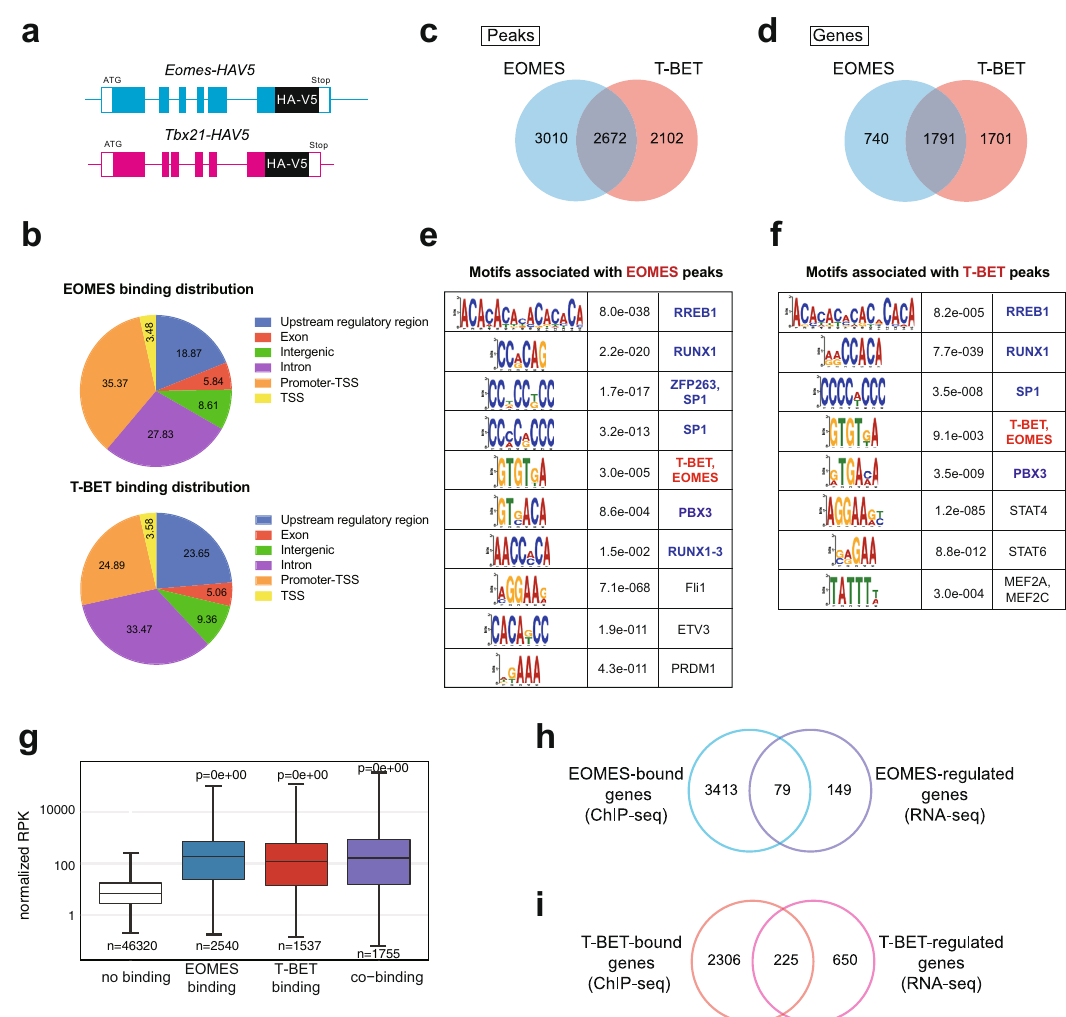
Fig. 8 Identi fi cation of direct T-BET and EOMES targets using novel KI mice. a Scheme of knock-in Eomes and T-bet HAV5 constructs. b Distribution of EOMES and T-BET peaks relative to different genomic features. “ Upstream regulatory regions ” refers to regions located − 20 kb/ − 1 Kb away from the TSS, “ promoter-TSS ” refers to regions located − 1 Kb/ + 100 bp around the TSS and “ TSS ” refers to regions located − 100 bp/ + 1 Kb around the TSS. c Venn diagram showing the overlap between EOMES and T-BET ChIP-seq peaks. d Venn diagram showing the overlap between genes nearby EOMES and T-BET ChIP-seq peaks. e – f Motifs associated with ( e ) EOMES or ( f ) T-BET peaks and corresponding TFs ( E -values are shown, not ranked). g Boxplot presenting expression (RNA-seq data) of genes bound by T-BET and/or EOMES (Chip-seq data). Expression of genes without any of them is shown as reference. The number of genes analyzed is indicated in the fi gure. Minimal and maximal values are shown. The centre gives the mean expression and the box gives the 10 – 90 percentile. P values were calculated by Wilcoxon signed-rank tests. h Venn diagram showing the overlap between EOMES-bound (ChIP-seq) and EOMES-regulated genes (RNA-seq). i Venn diagram showing the overlap between T-BET-bound (ChIP-seq) and T-BET-regulated genes (RNA-seq). In panels ( c , d , h , i ) p values were calculated through hypergeometric tests and were p = 0; 0; 5.61133e-40; and 6.440556e-96,